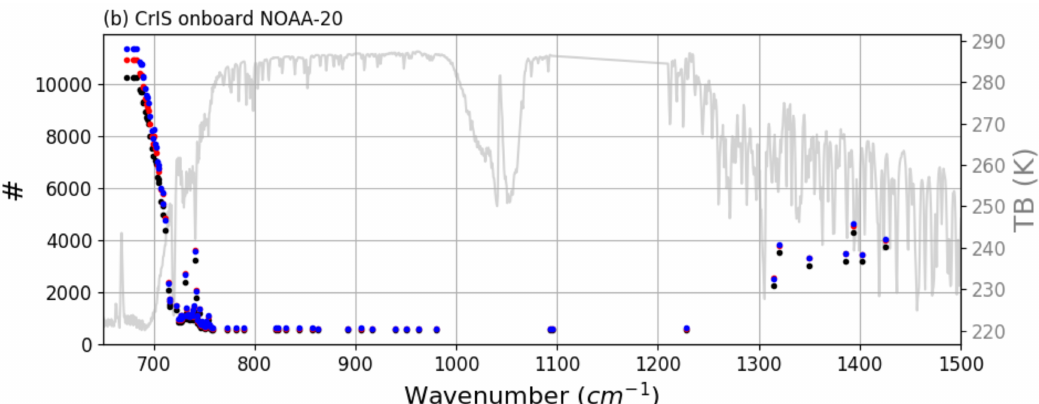
Figure 5. The spectral distribution of mean assimilated data number of assimilated CrIS channels onboard ( a ) S-NPP and ( b ) NOAA-20 satellites for three trial runs for the period from 7 July to 22 August 2018. Black, red, and blue circles indicate the control, latency_20m, and latency_5m runs, respectively. Greyline means the reference brightness temperatures of CrIS 2211 channels in FSR mode.